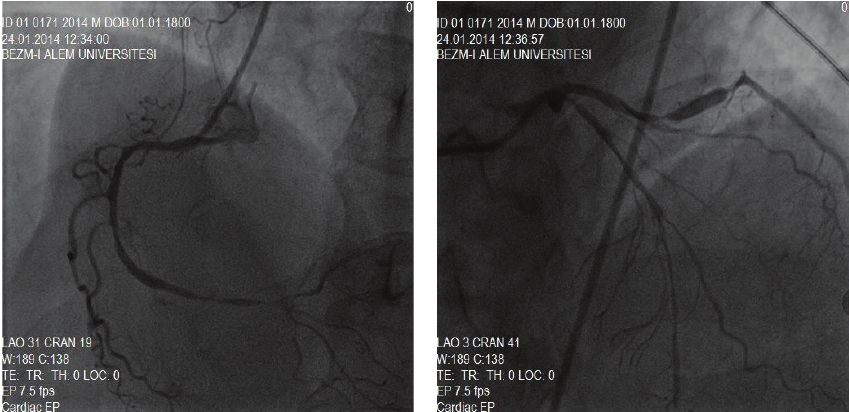
Figure 2: Multiple diffuse narrowing on right coronary artery, left anterior descending artery, and circumflex